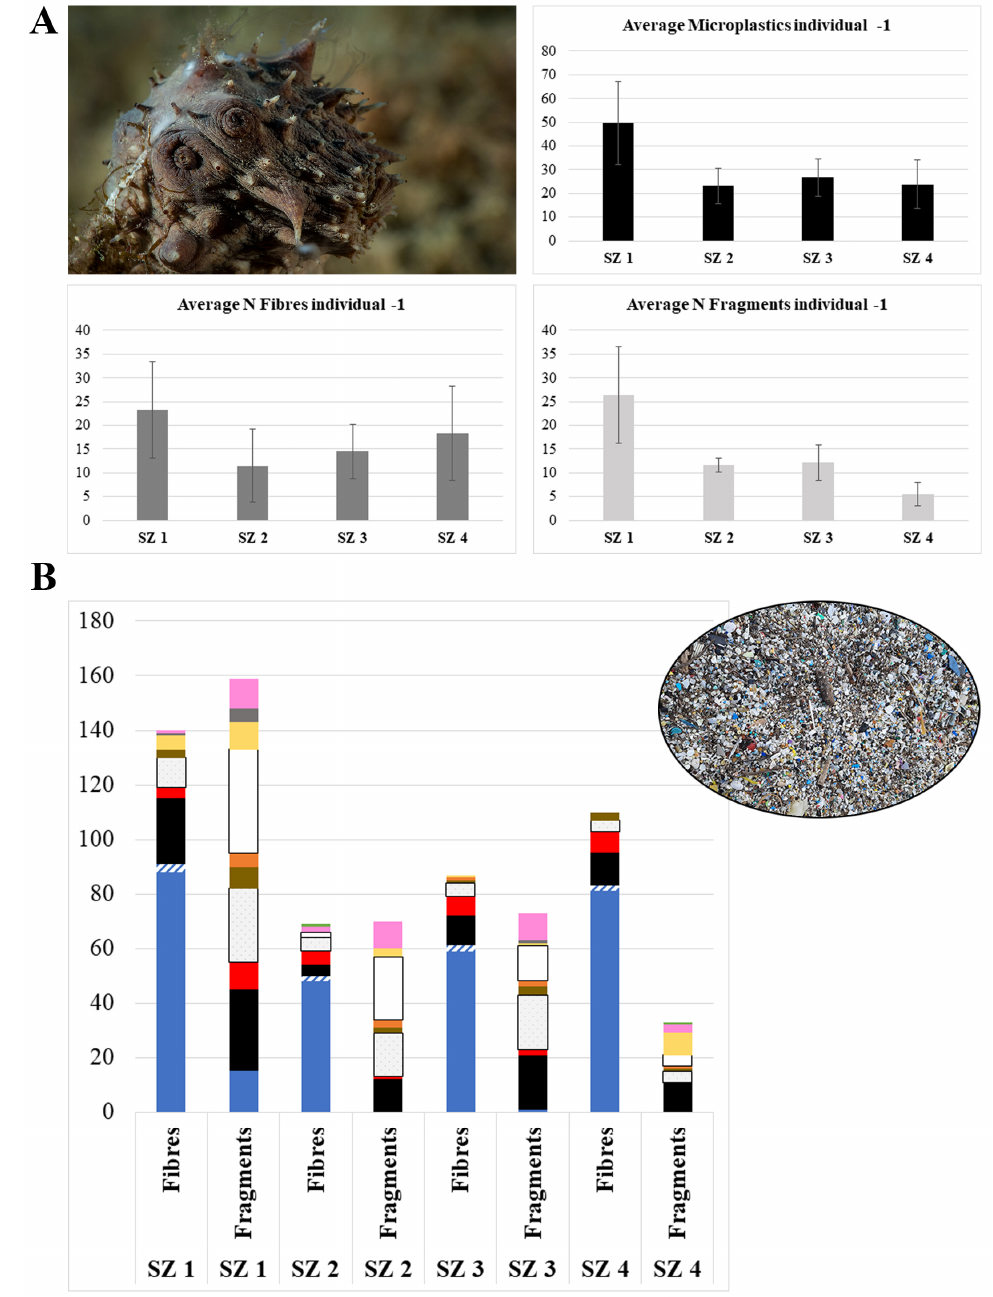
Figure 5. ( A ) Comparison of the sampling sites’ potential variation in microplastics in Holothuria tubulosa . Bars represent mean ± standard deviation. ( B ) Analyses of the colors of all the extracted microplastics grouped according to stations. SZ 1—“Chiapparo”, Santa Caterina, Nardò; SZ 2— “Torre Vado”, Morciano di Leuca; SZ 3—“Grotta Verde”, Tricase; SZ 4—“Torre Guaceto” M.P.A., Brindisi. The colors of the different rectangles reflect the real colors of the microplastics analyzed.